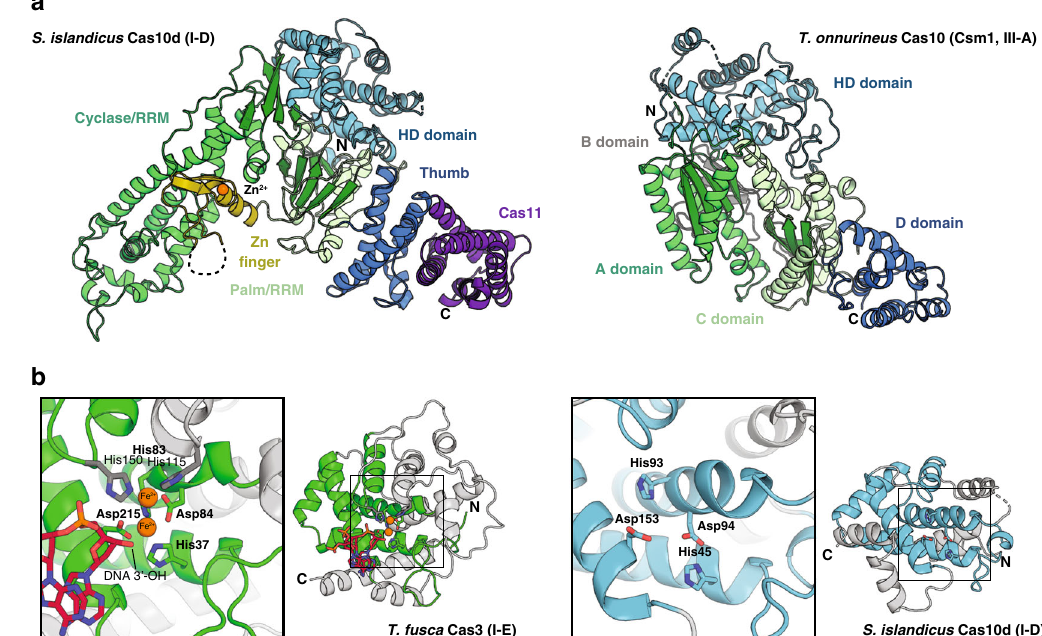
Fig. 2 Domain structure of S. islandicus Cas10d. a Left, overview of the domain structure of S. islandicus Cas10d (type I-D, this work) with colours as in Fig. 1. The location of the N and C termini as well as the Zn 2 + ion (orange sphere) of the zinc fi nger are indicated; Right, the structure of the T. onnurineus Cas10 (Csm1, type III-A, PDB ID 4UW2) in an approximately aligned orientation 25 . The B domain is an additional domain found adjacent to the zinc fi nger motif in Csm1, not present in Cas10s (Supplementary Fig. 1). b Details of the HD nuclease domain found in T. fusca Cas3 (left, type I-E, green, PDB ID 4QQW) and S. islandicus Cas10d (this work, right, type I-D, blue) which are structurally homologous 15 . The HD domains are aligned on the active site and the conserved core of 6 – 7 helices shown with colours. Highly conserved residues in the active site (HD, D, H) are shown in coloured sticks with labels in bold type in the zoomed views and additional metal-coordinating residues in T. fusca Cas3 with grey sticks and regular type. Two Fe 2 + ions and DNA nucleotides present in this structure are shown with orange